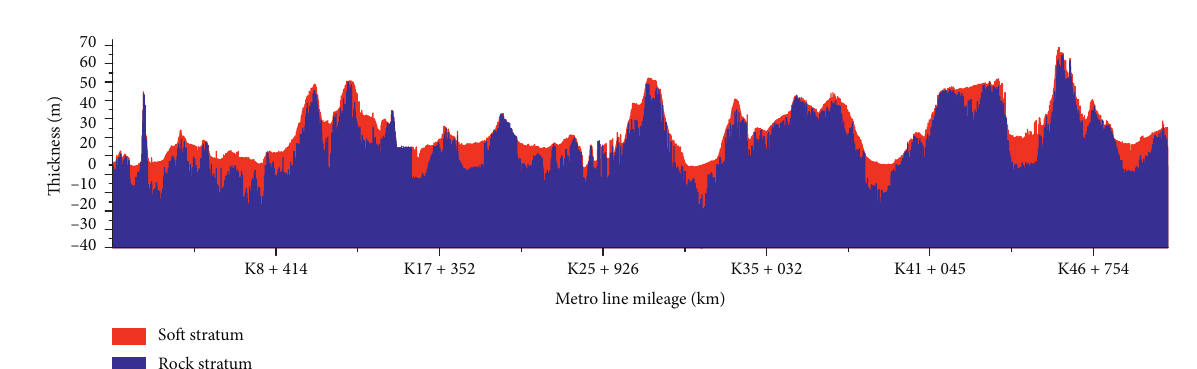
Figure 10: Distribution map of the dualistic stratum structure along the